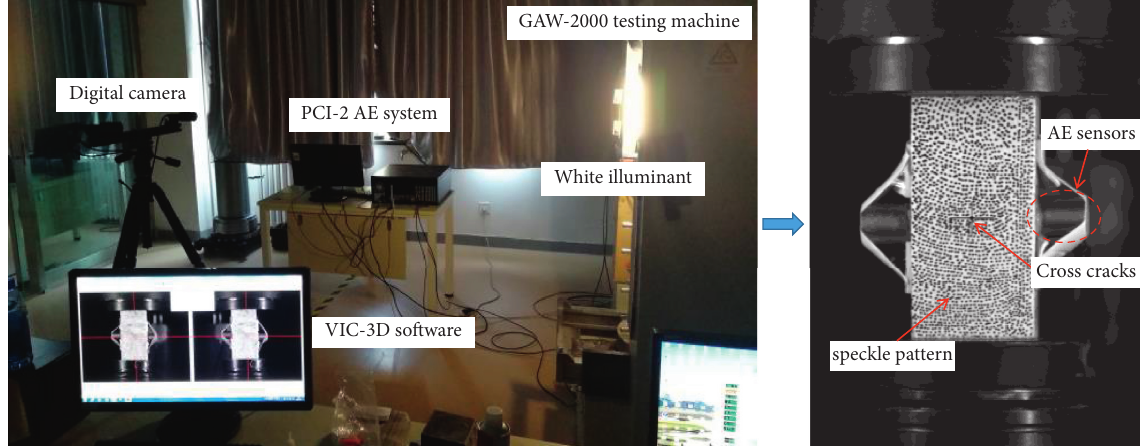
Figure 3: Testing